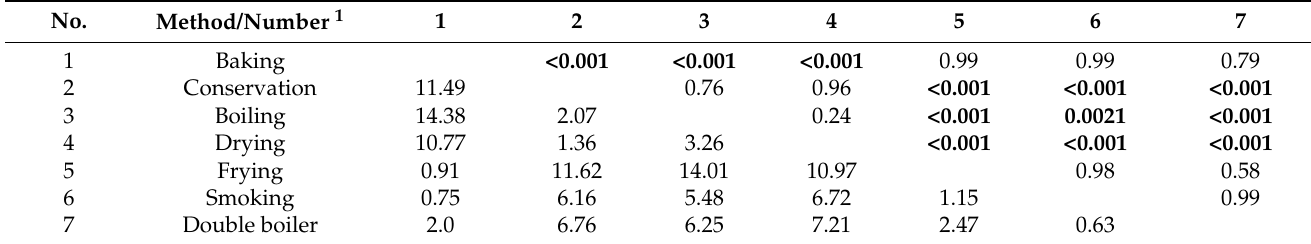
Table 3. Pairwise comparison for no difference between the ANN predicted data groups (grouped by type of processing of raw